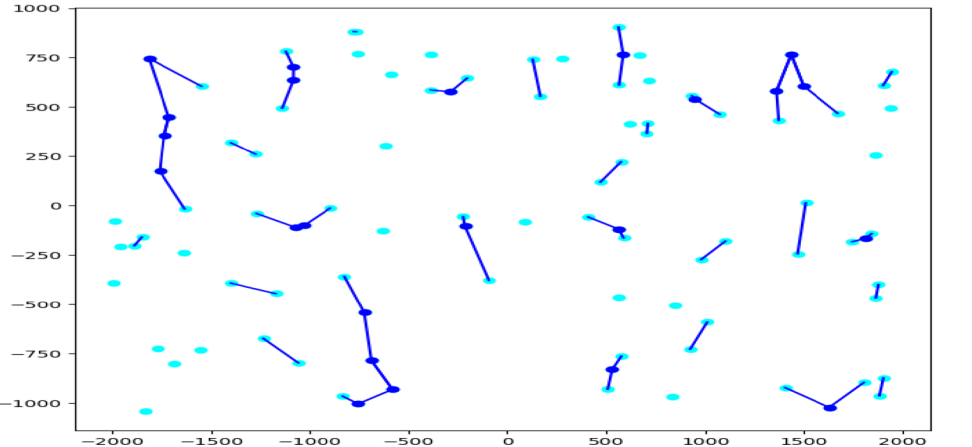
Figure 4. First phase partial solution constructed with the ML predictions. Vertices in light blue are free for the second phase of ML-Constructive . The instance is the KroA100 from the TSPLIB